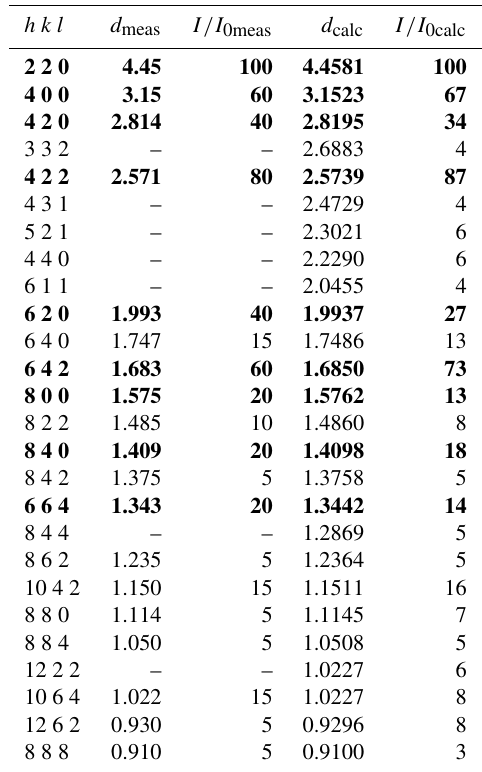
Table 4. Measured and calculated X-ray powder diffraction data ( d in Å) for monteneveite. The strongest diffraction lines are given in bold.